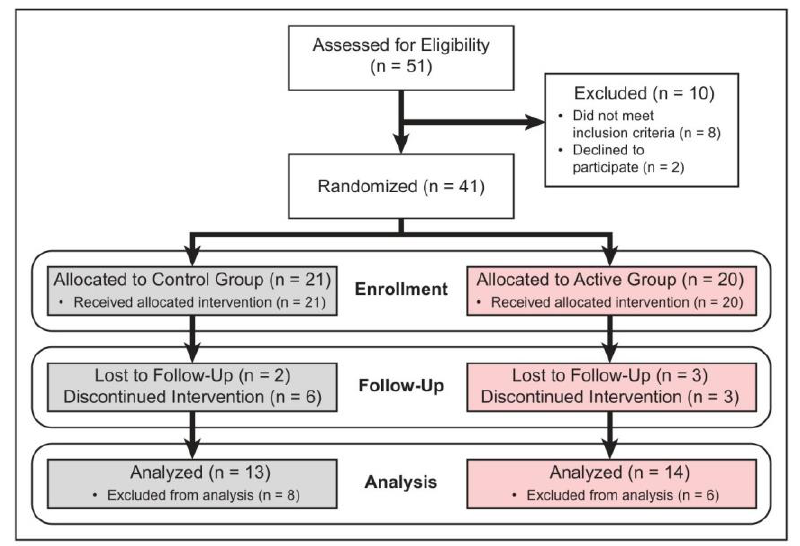
Figure 2. Study consort flow diagram demonstrating the method of patient